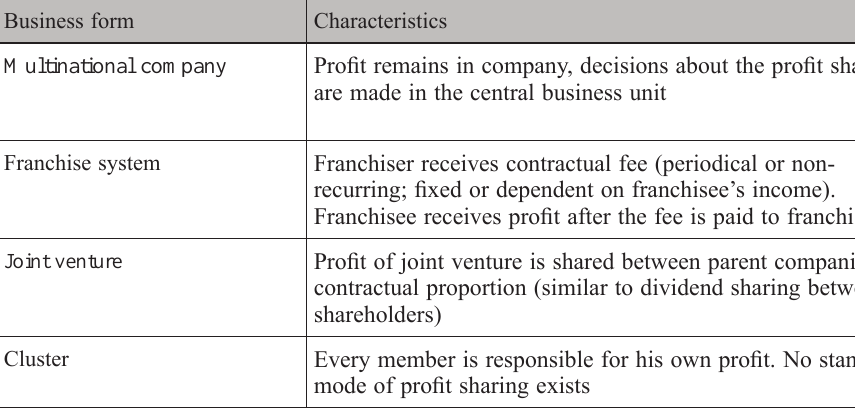
Table 2. Profit sharing in different business collaboration structures Business